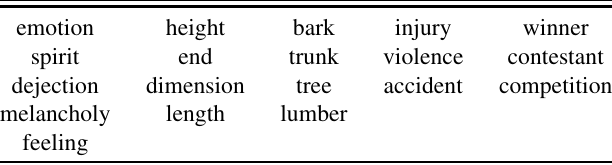
TABLE II. Each column lists examples of strongly connected components in the dictionary graph consisting of links involved in short ( (cid:2) 5 ) cycles.